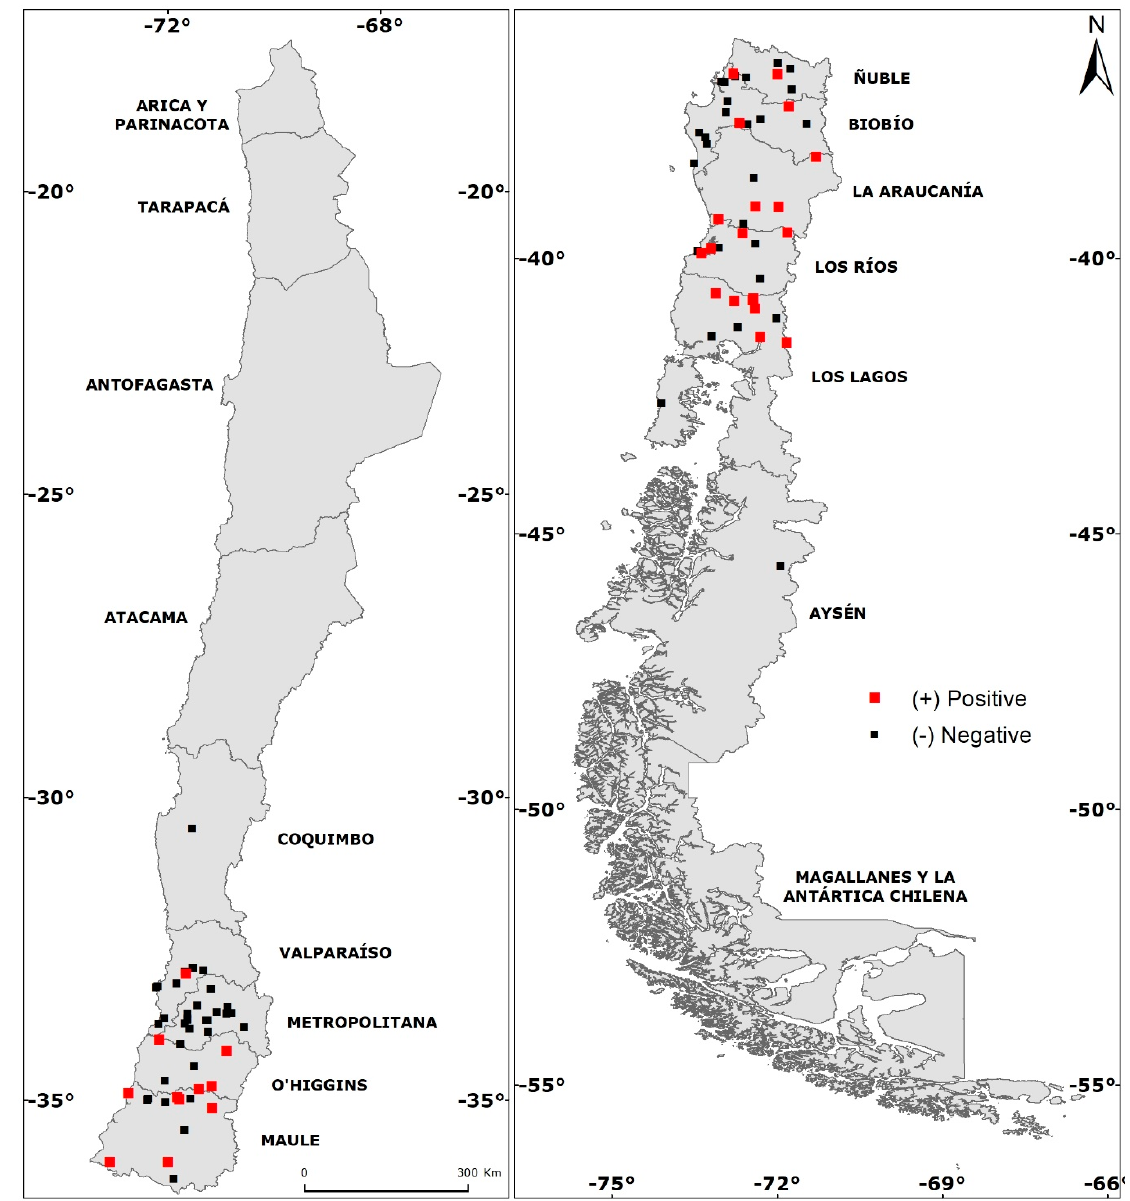
Figure 1. Small mammal trapping sites associated with human hantavirus cases sampled in the nineteen-year study across administrative regions in Chile. Sites with small mammals seropositive for anti- Andes orthohantavirus (ANDV) antibodies are shown in red. Sites without seropositive rodents are shown in black.